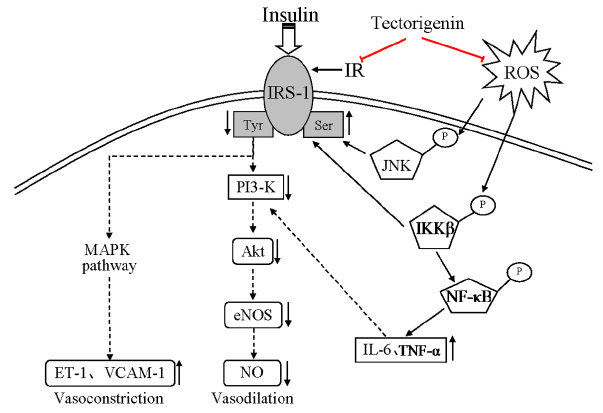
Figure 9. Schematic representation of the effects of tector- igenin to block hyperglycaemia-induced vascular endothelial